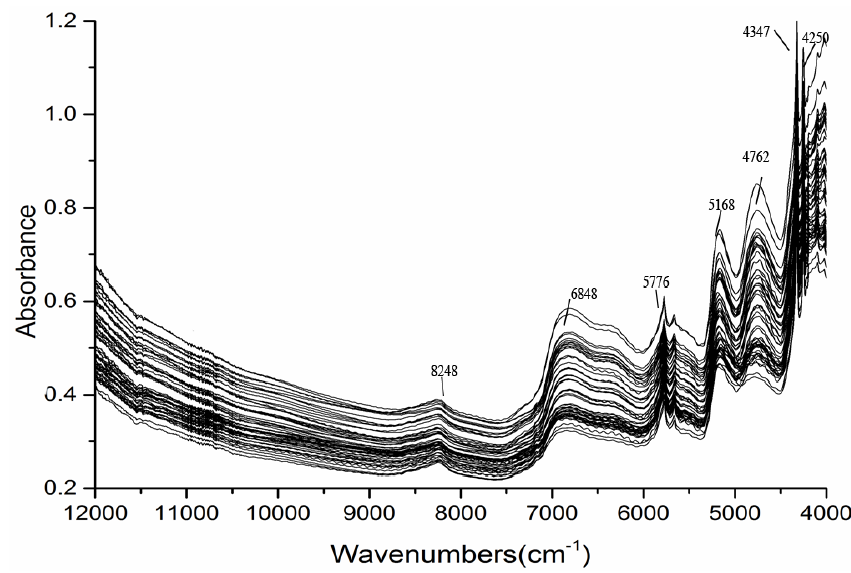
Figure 2. NIRS spectra of 150 batches of Rhizoma Cimicifugae.